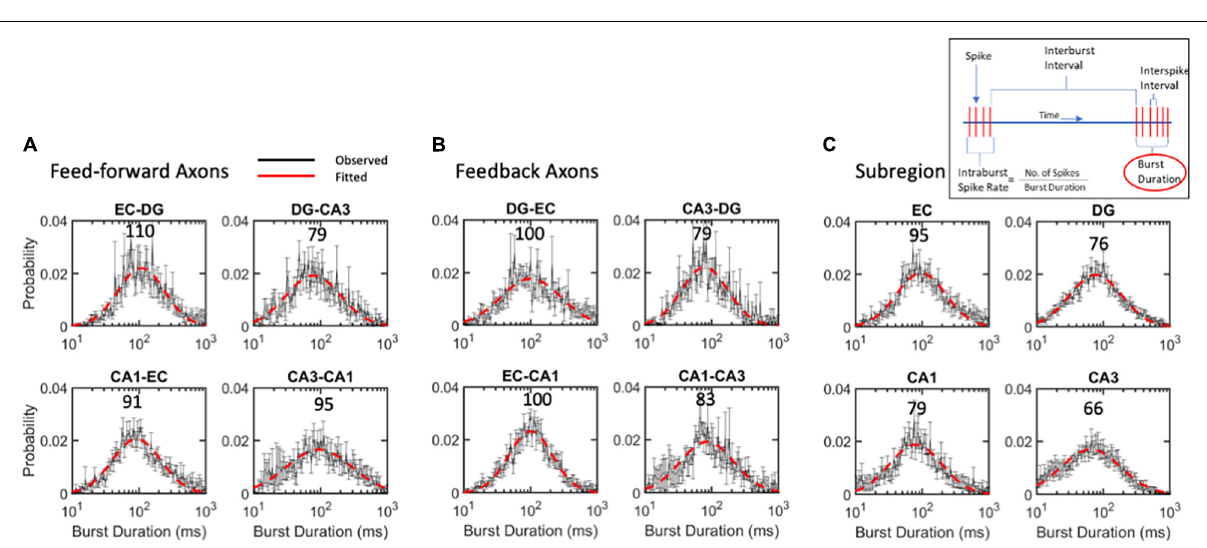
as bumps in the distribution in feedback CA1-CA3 axons around 300 Hz ( Figure 6B ) and neurons in the EC (200 Hz) and CA1 and CA3 subregions (400 Hz) ( Figure 6C